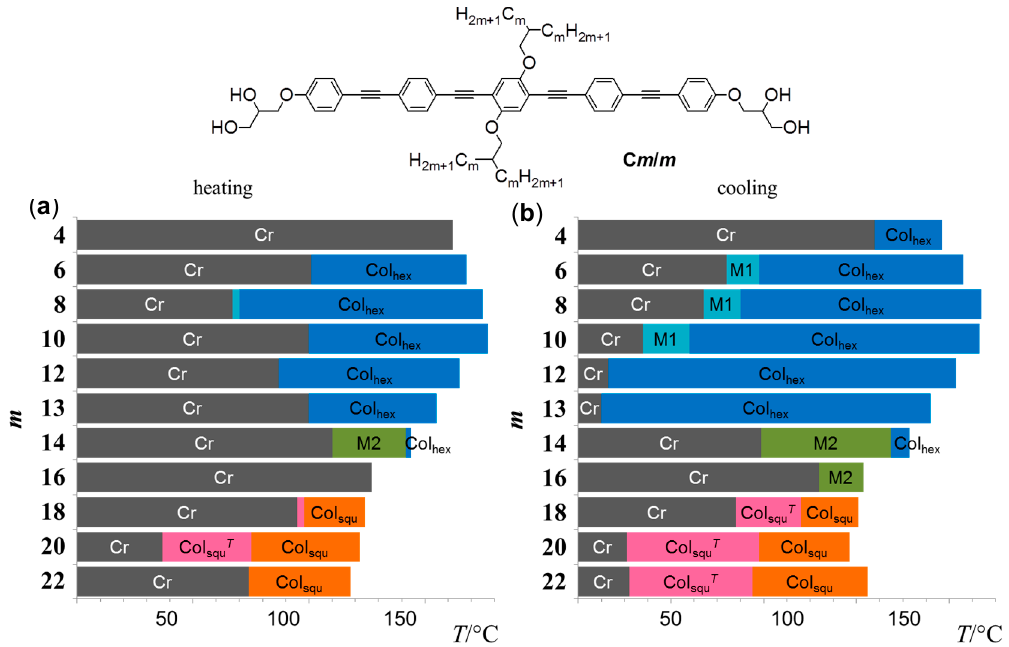
Figure 4. Bar diagrams showing the phase sequences and transition temperatures of compounds C m/m depending on the length m ( a ) as observed on heating and ( b ) on cooling with 10 K · min − 1 ; for abbreviations, see Figure 2 and Table 1.